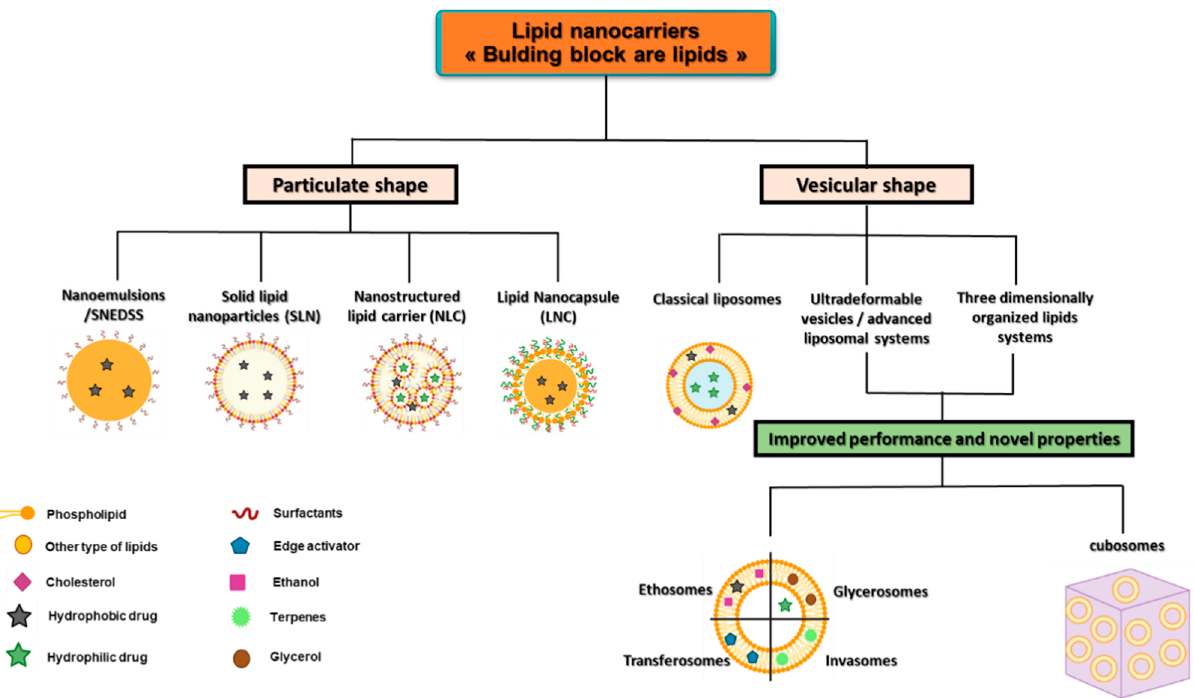
Figure 2. Classification of the main types of lipidic nanosystems for dermal and transdermal drug delivery. Adapted with permission from [62] and Elsevier B.V Amsterdam.